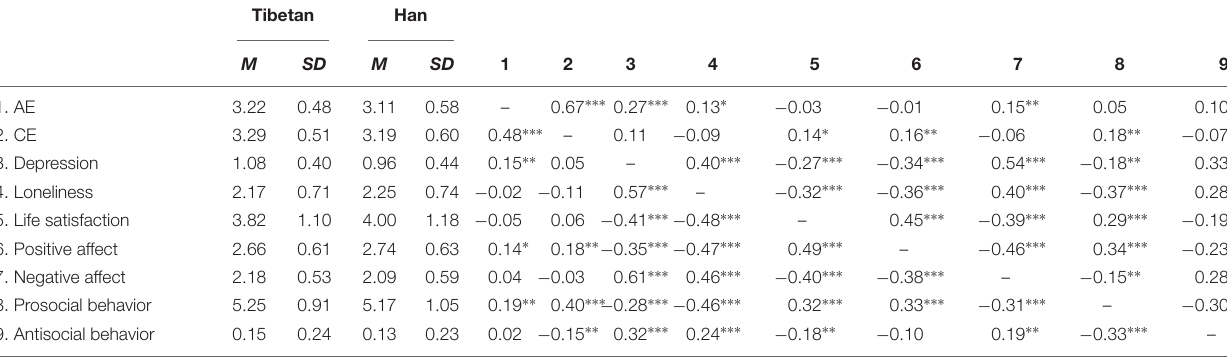
TABLE 1 | Descriptive statistics and bivariate correlations of study variables for Tibetan and Han adolescents. Tibetan Han